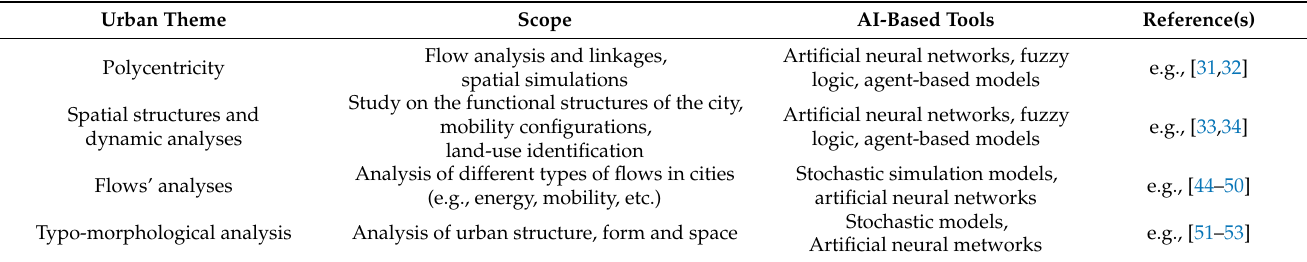
Table 1. Examples of AI-based approaches in city